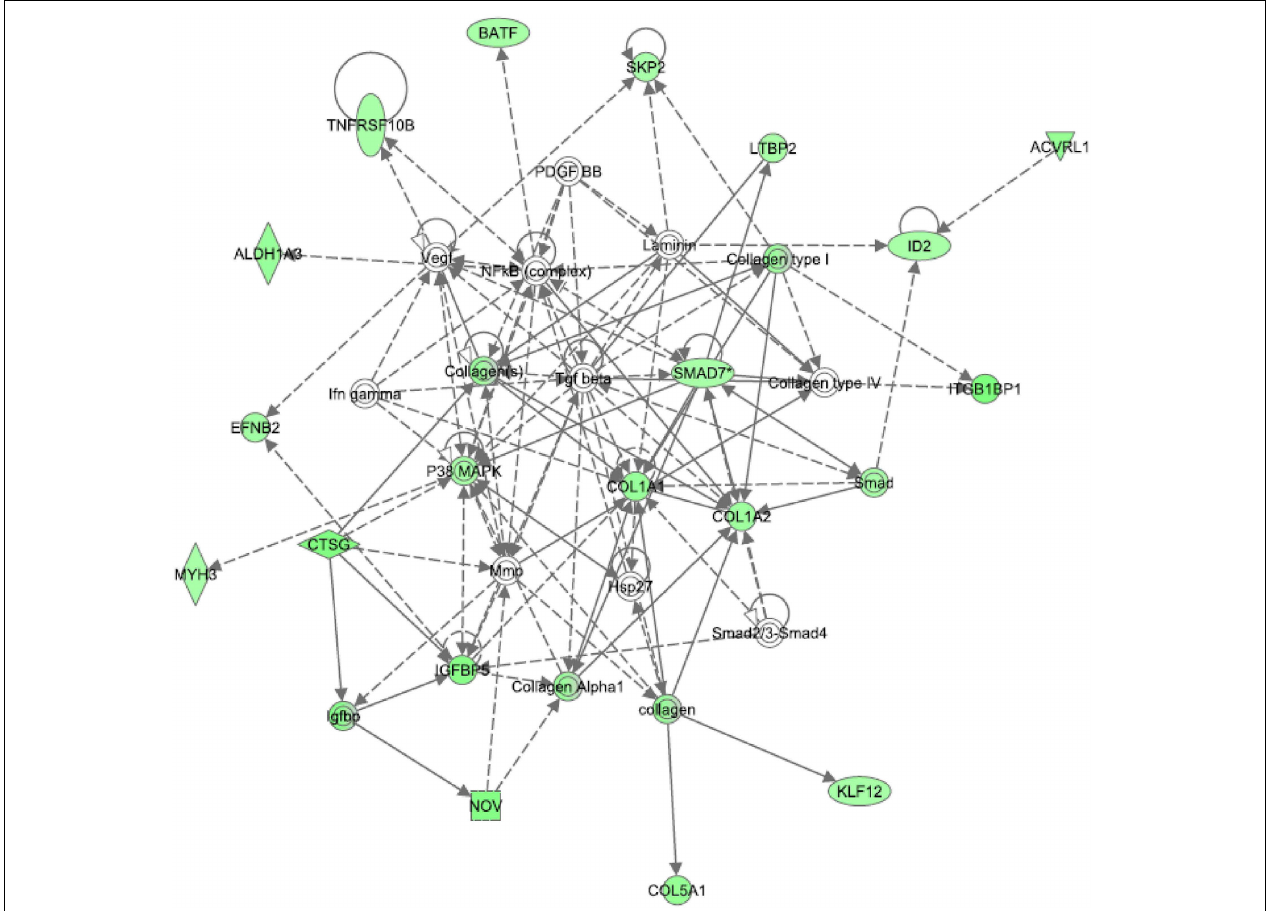
We selected eight transcripts for real-time PCR validation,